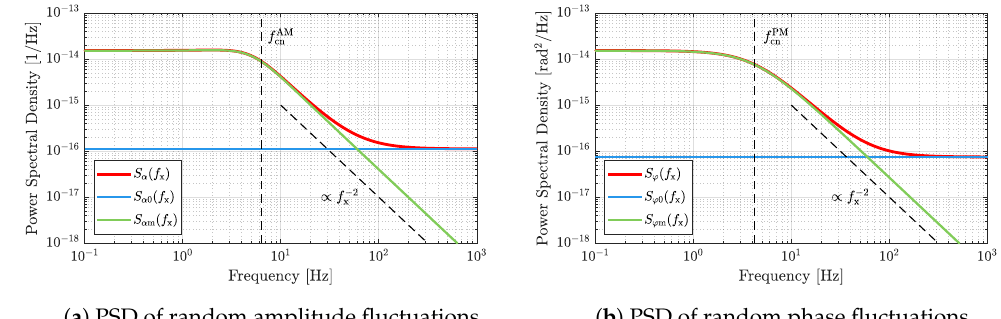
Figure 7. Illustrations of the power spectral densities (PSD) of random amplitude fluctuations ( a ) and random phase fluctuations ( b ). Both are composed of a constant component due to the thermal electrical noise of the dielectric and a frequency-dependent component due to the thermal mechanical noise. The plots are based on the sensor parameters summarized in Table